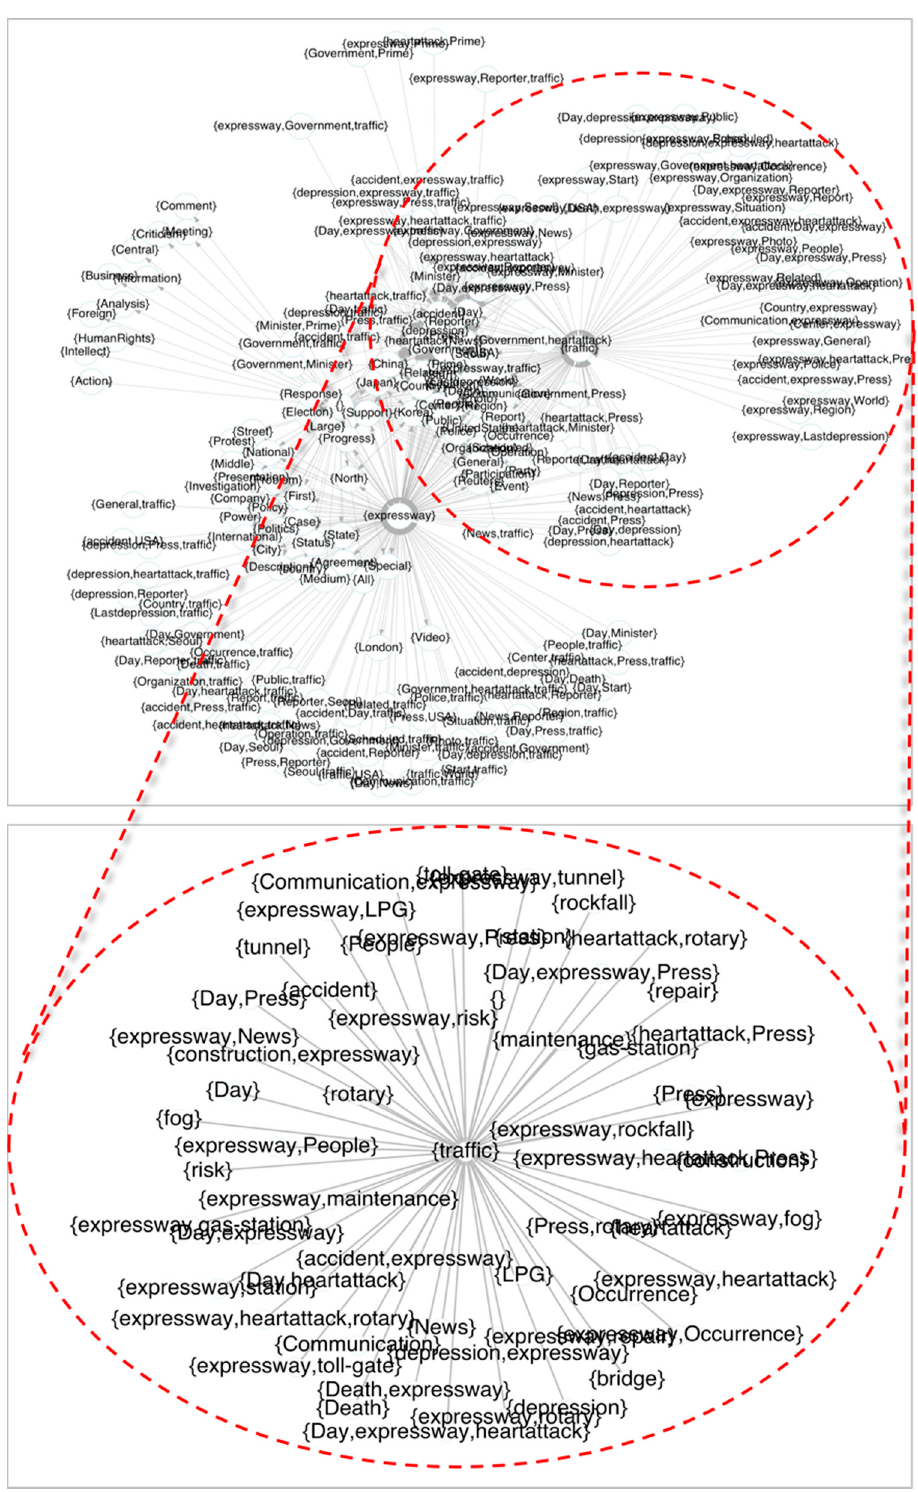
Figure 6. Knowledge Graph of Association Words.